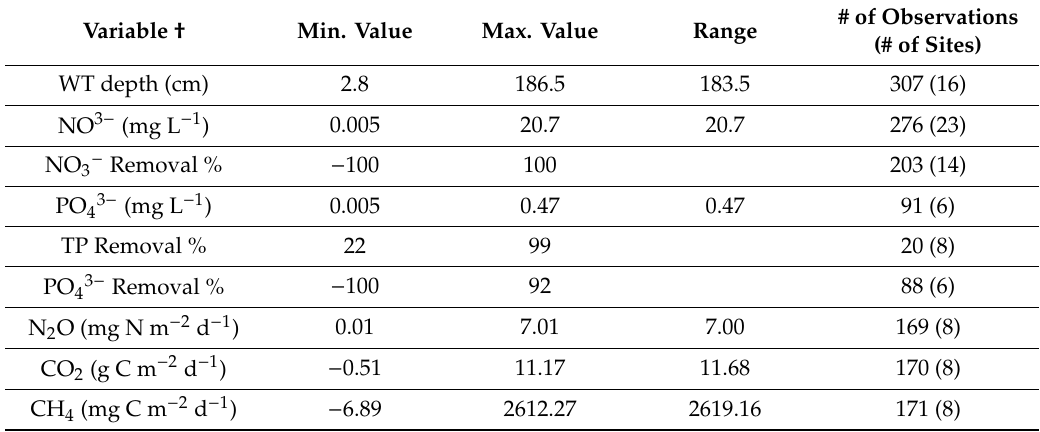
Table 2. Summary of data used for the development of individual models in